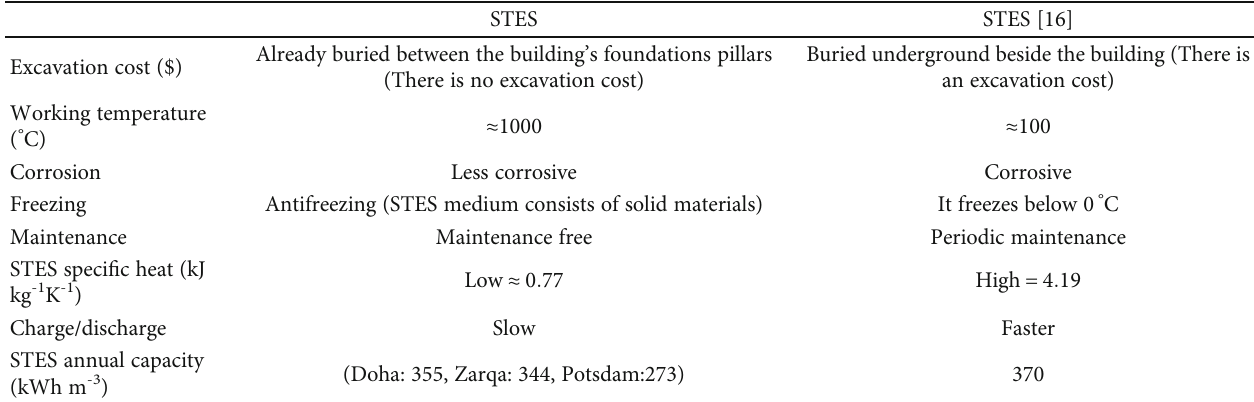
Table 6: Comparison between this study and the reference used for the simulation ’ s validation.